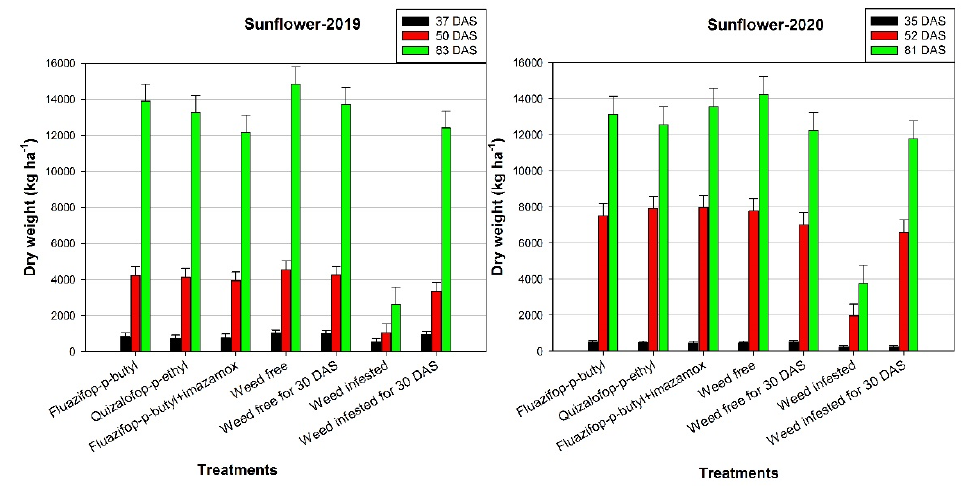
Figure 4. Effects of various control treatments of Johnsongrass on dry weight (kg ha − 1 ) of sunflower at different days after sowing (DAS), in 2019 and 2020. For each sampling date, error bars indicate the LSD 5% value.